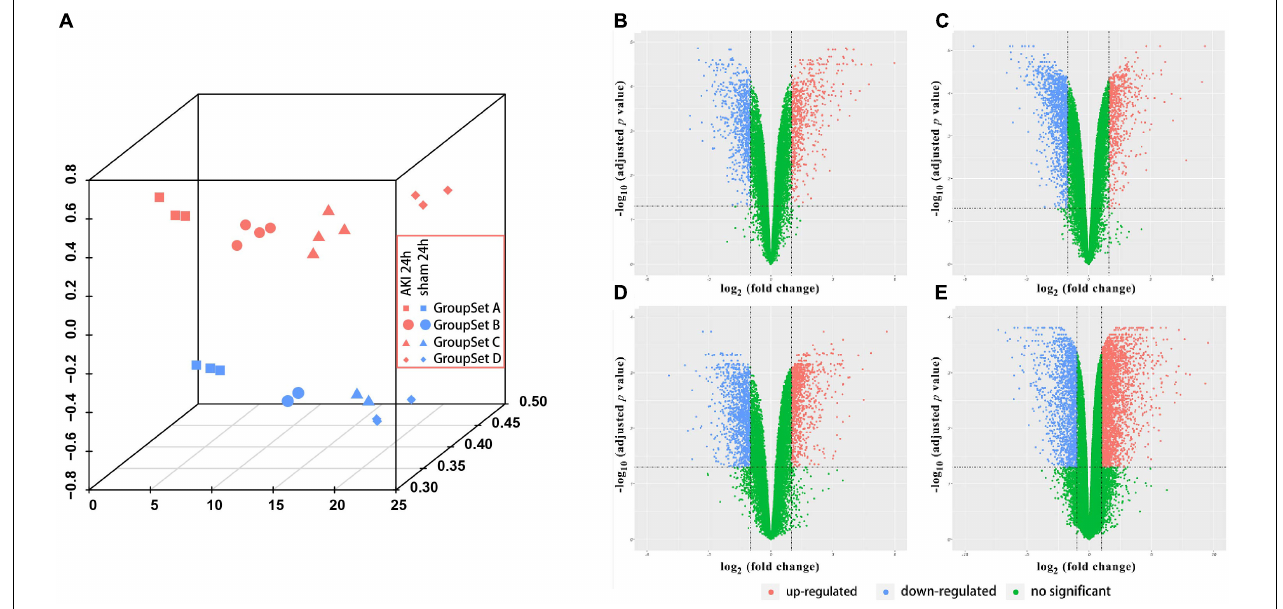
FIGURE 1 | Principle component analysis (PCA) plot and differential expression data between AKI 24 h and sham 24 h groups in all four GroupSets. (A) PCA plot shows the tight clustering of biological replicates and distinct clustering between AKI 24 h and sham 24 h conditions in all four GroupSets. Differential expression data between AKI 24 h and sham 24 h groups in (B) GroupSet A data, (C) GroupSet B data, (D) GroupSet C data, and (E) GroupSet D data. The criteria for statistically significant difference of DEGs was adjusted p < 0.05 and |log2 fold change (FC)| ≥ 1 in